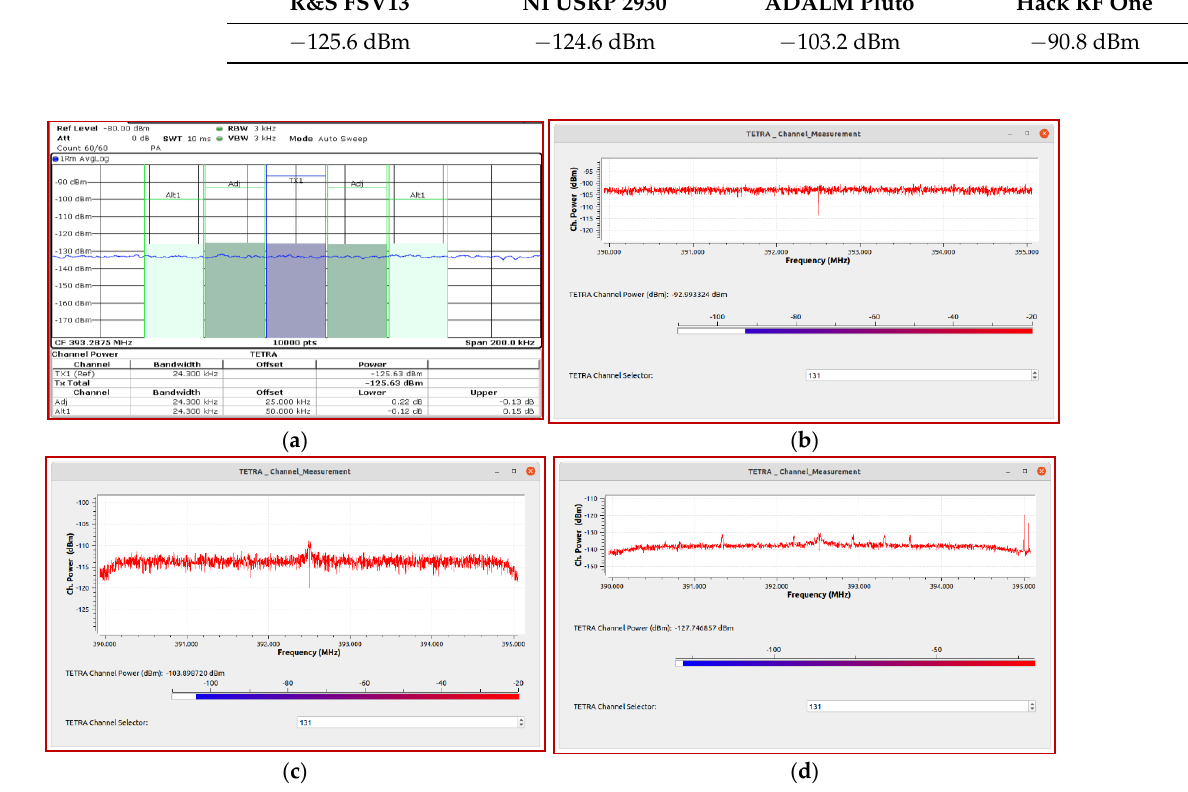
Figure 11. Display average noise level in the frequency band (390–395) MHz: ( a ) R&S FSV13; ( b ) HackRF One; ( c ) ADALM Pluto; ( d ) NI USRP 2930.